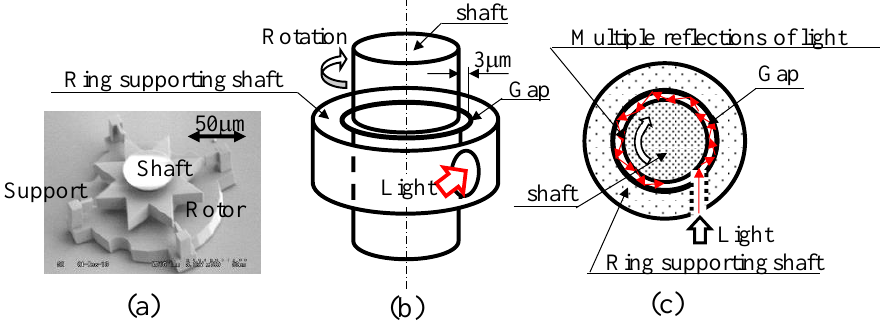
Figure 6. Application of light-based friction-reduction mechanism to micro rotor: ( a ) Micro rotor fabricated by 3D printer, ( b ) Concept of light introduction method for friction reduction, ( c ) Multiple reflections of light in gap between shaft and rotating ring (top view).